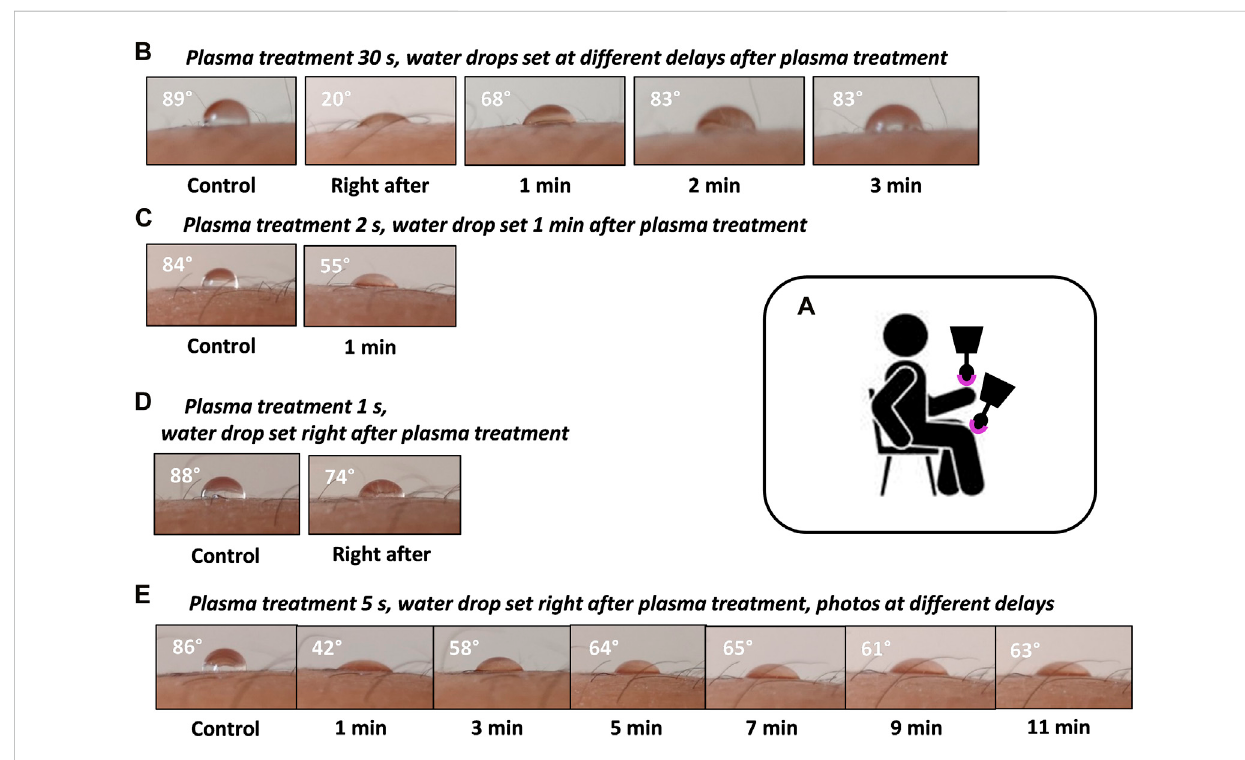
FIGURE 12 (A) Schematic for dielectric barrier discharge treatment of the hand and knee. Photographs of a 20-µL water drop set on the author ’ s hand for (B) top:noplasmatreatmentand30-sDBDtreatmentwithwaterdropsetatdifferentdelays(rightafter,1,2and3 min), (C) secondrow:notreatmentand2-s DBD treatment with drop set 1 min later. (D) Third row: no treatment and 1-s plasma treatment with drop set right after. (E) Bottom row: 5-s DBD treatment water drop set right after and photographs taken with a 1- to 11-min delay. The angle indicated on each photograph is the average of the left and right water contact